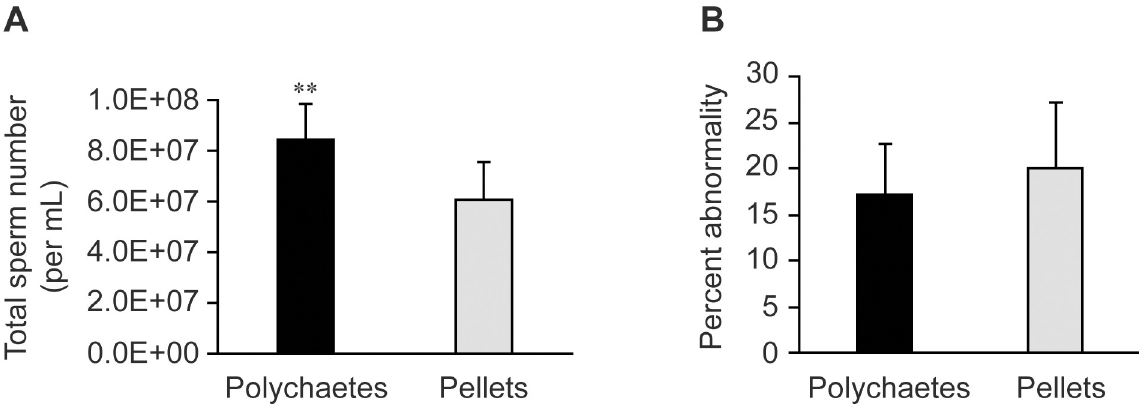
Fig 6. Total sperm counts and percentage of sperm abnormality in domesticated shrimp fed with polychaetes and feed pellets. Spermatophores of domesticated shrimp fed with either polychaetes (black bar, N = 8) or commercial feed pellets (gray bar, N = 8) were used in the analysis to determine (A) total sperm counts and (B) percentage of sperm abnormality. Error bars represent standard deviations. Asterisks indicate a significant difference between samples using the t -test ( �� for P < 0.01).